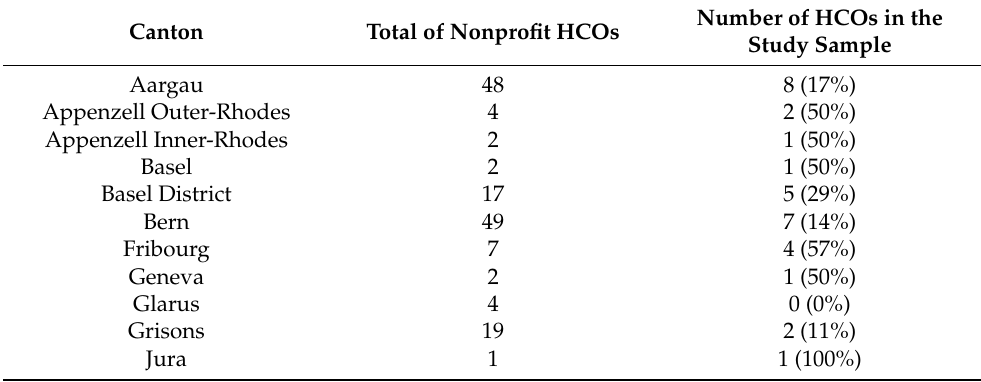
Table A2. Number of home care organizations in the study sample ( n = 70), by canton.